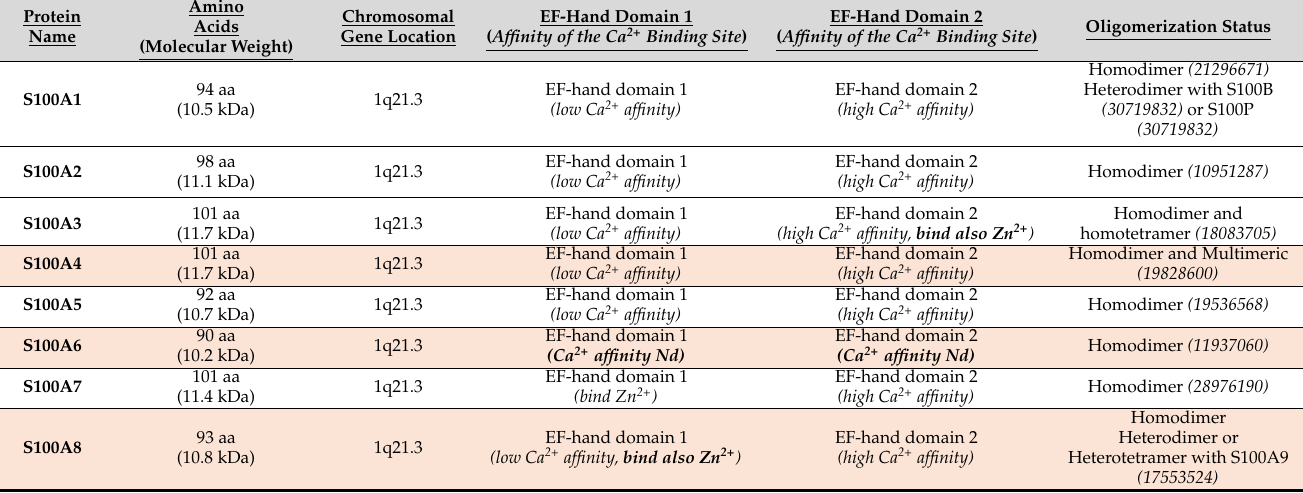
Table 1. Structural characteristics of human S100 protein members. S100 members highlighted in brown are the isoforms predominantly expressed in liver cells (see Figure 2) and described in this review as contributing to liver disease development. Data are extracted from the ExPASy database (https://www.expasy.org/resources/nextprot (accessed on 12 September 2022)). When available, PMIDs of publications describing the multimerization state of the specific S100 isoform are indicated in parenthesis. Nd: not